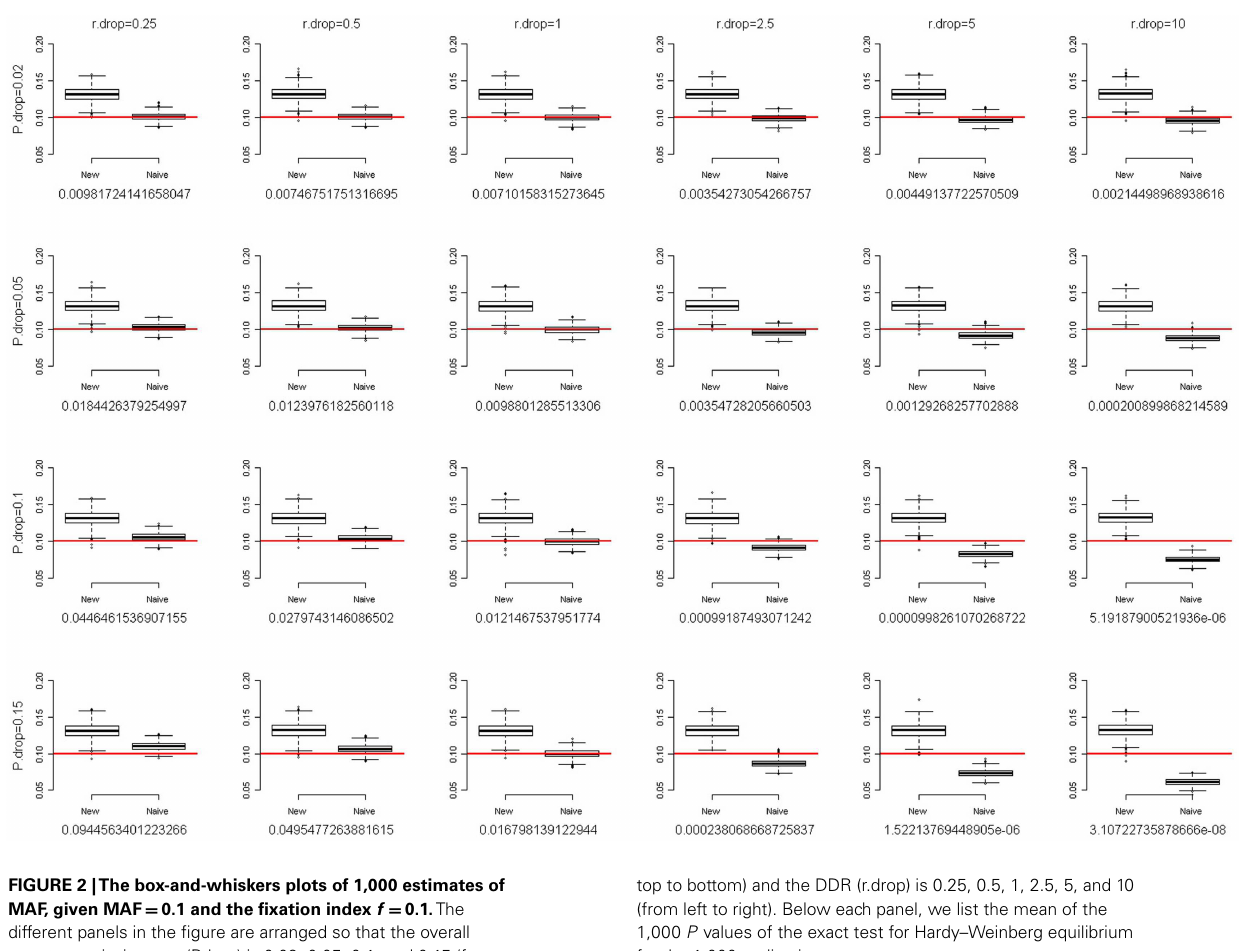
top to bottom) and the DDR (r.drop) is 0.25, 0.5, 1, 2.5, 5, and 10 (from left to right). Below each panel, we list the mean of the 1,000 P values of the exact test for Hardy–Weinberg equilibrium for the 1,000